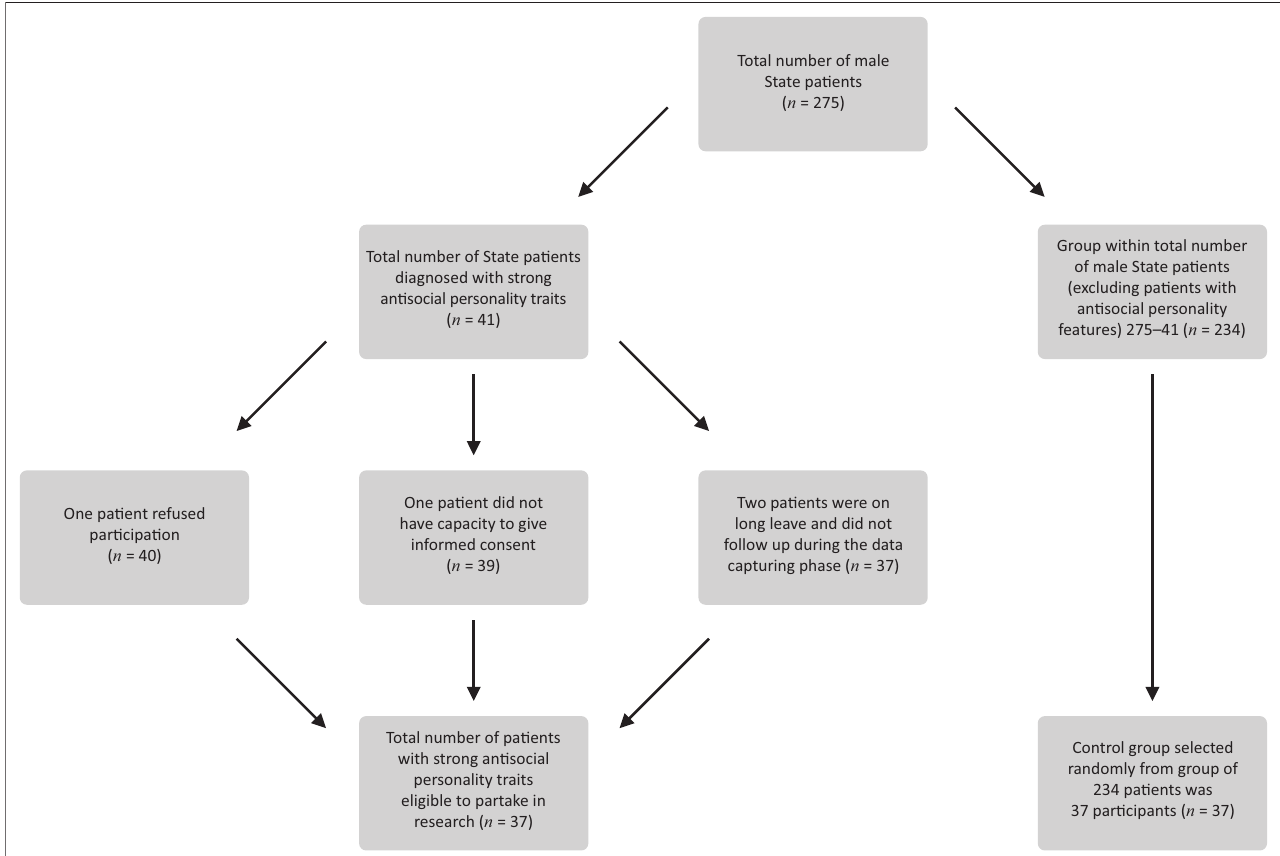
FIGURE 1: Formation of study